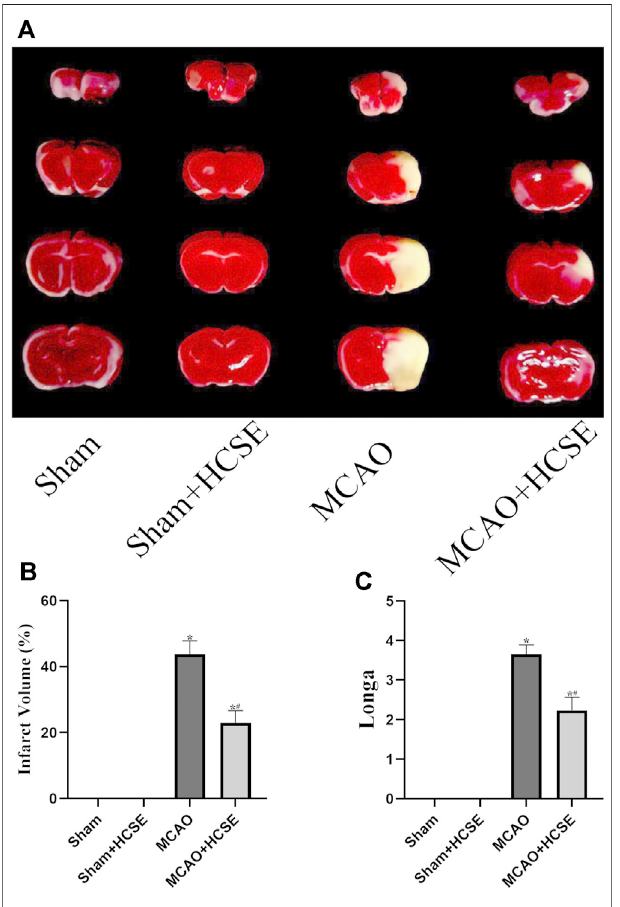
FIGURE6| Theneuroprotectiveeffects ofHCSE. (A) TTCstaininginthe Sham, Sham + HCSE, MCAO and MCAO + HCSE groups. (B) The infarct volume was expressed as the ratio of (infarct volume/the whole brain volume) × 100%. (C) Longa score. ( n = 7 per group; * p < 0.05, signi fi cantly differentfromthecorrespondingShamgroup,# p < 0.05, signi fi cantlydifferent from the MCAO group).